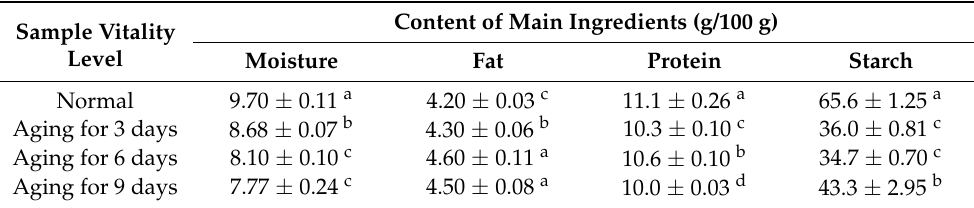
Table 4. Test results of the four components in different vitality grade seeds.